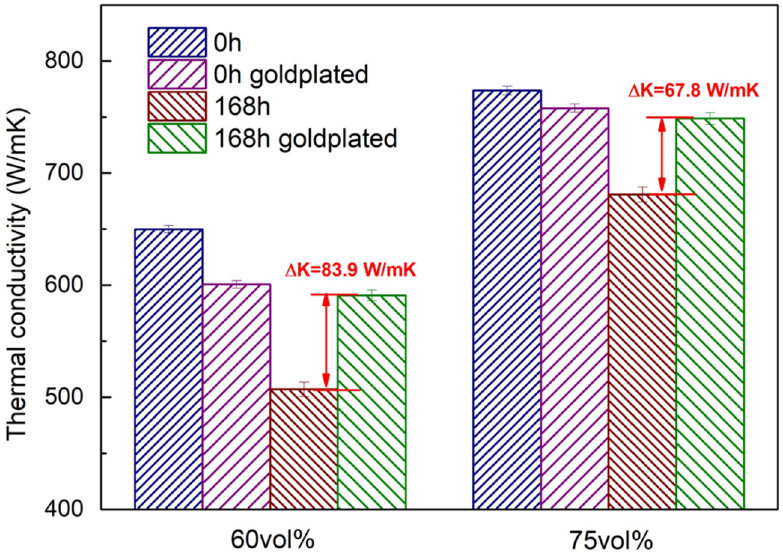
Figure 7. Thermal conductivity of Diamond/Cu composites before and after 168-h neutral salt spray test.